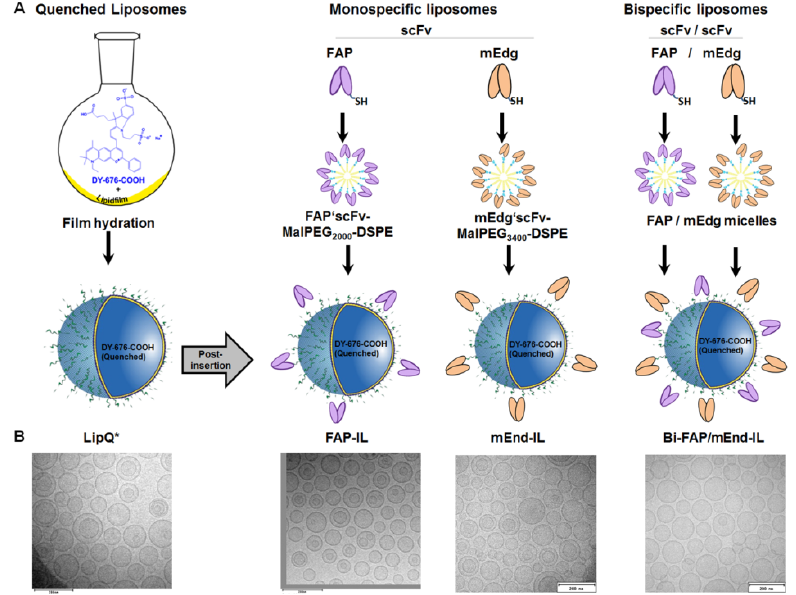
Figure 1. Scheme for the preparation of activatable bispecific fibroblast activation protein (FAP) and murine endoglin targeting liposomes. ( A ) The lipid film hydration was used to prepare liposomes (LipQ*) with high concentrations of quenched DY-676-COOH in the aqueous interior. Single chain antibody fragments (ScFv)-conjugated micelles specific for human FAP or murine endoglin were post-inserted in the quenched liposomes either individually to get the monospecific FAP-IL and mEnd-IL or simultaneously to get the bispecific Bi-FAP/mEnd-IL. Quenched Liposomes (LipQ) used as control were post-inserted with bare micelles. ( B ) Electron micrographs of the liposomes reveal a mix of unilamellar and a few multilamellar vesicles of approximately 100 nm diameter. Scale bar: 200 nm.